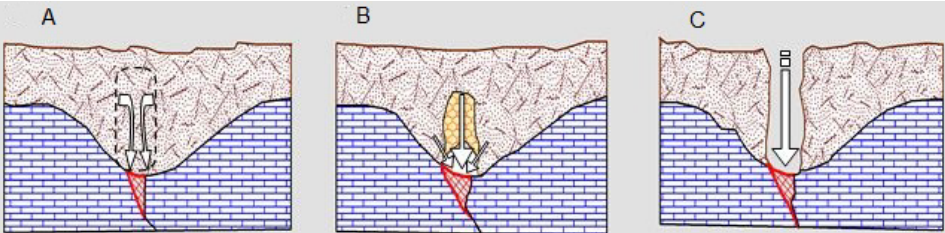
Figure 1. The mechanism of occurrence of cover collapse sinkholes. ( A ) existence of soil or non-continuous materials (units PlQc, PlQcm) or members with adhesive characteristics over the Oligo-Miocene limestones; ( B ) water flow washes soils over the karstic bedrock and transports it through big fractures into the underground parts; ( C ) the hole gets so big that the roof cave cannot bear the weight and collapse.